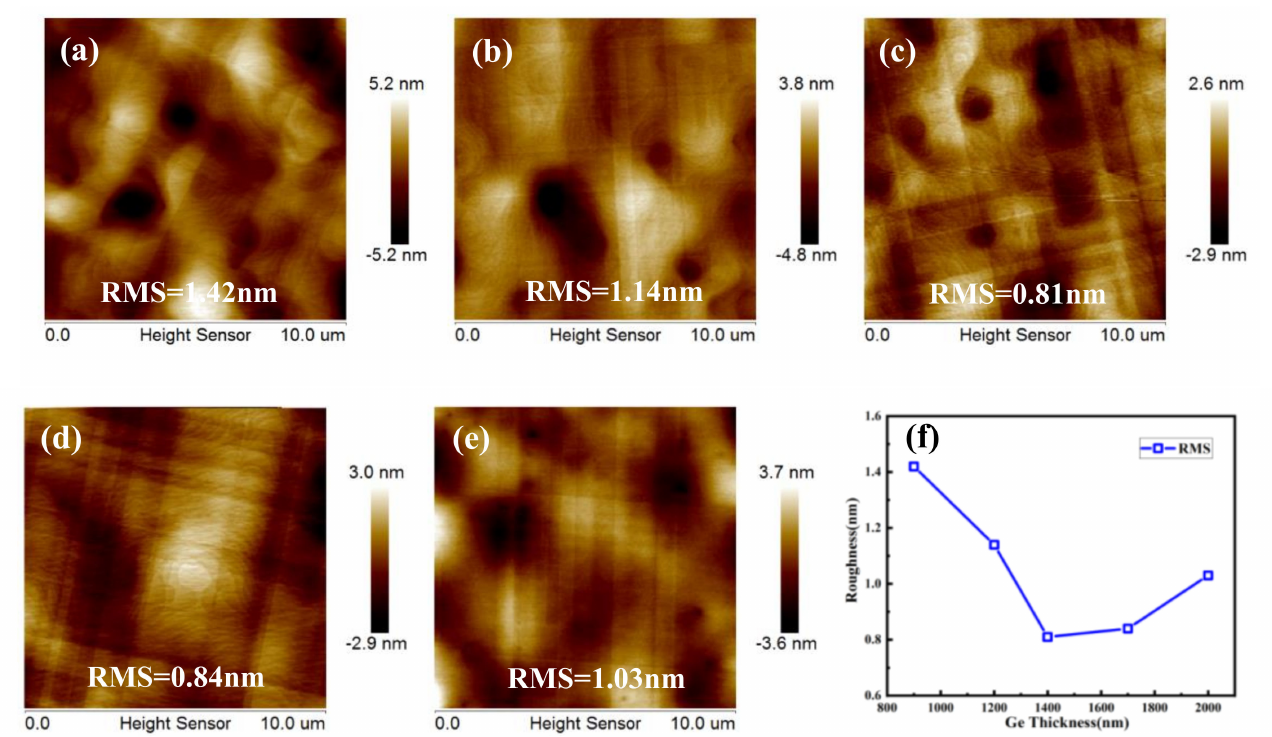
10 µ m 2 of Ge layers grown at 650 ◦ C with thicknesses of ( a ) 900, ( b ) 1200, ( c ) 1400 nm, Figure 11. AFM images 10 × ( d )1700 nm, and ( e ) 2000 nm. The RMS roughness of the samples were 1.42, 1.14, 0.81, 0.84, and 1.03 nm, respectively. ( f ) The plot of the RMS roughness of the five